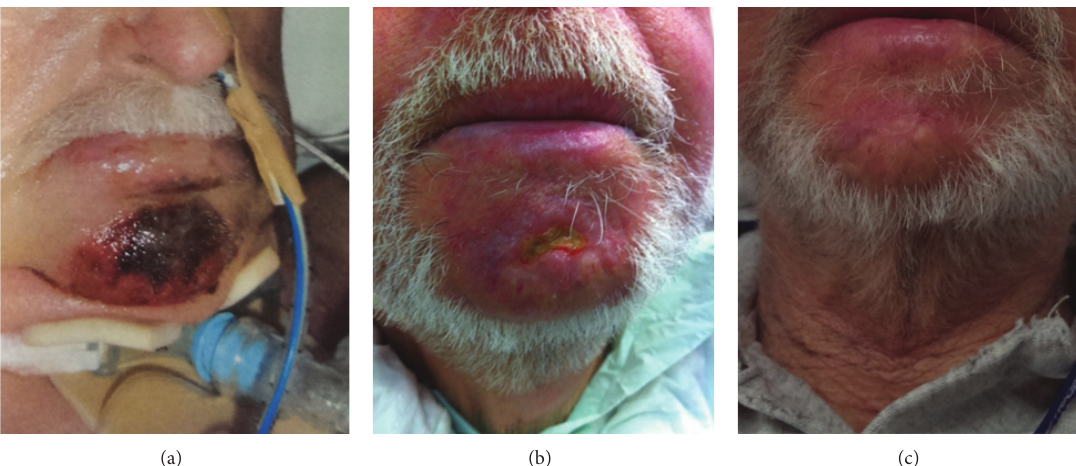
Figure 1: Pressure necrosis of the chin, noted first as a bruise (day 6), which developed an eschar which was left to autodebride (2 months) and later healed leaving a scar (3